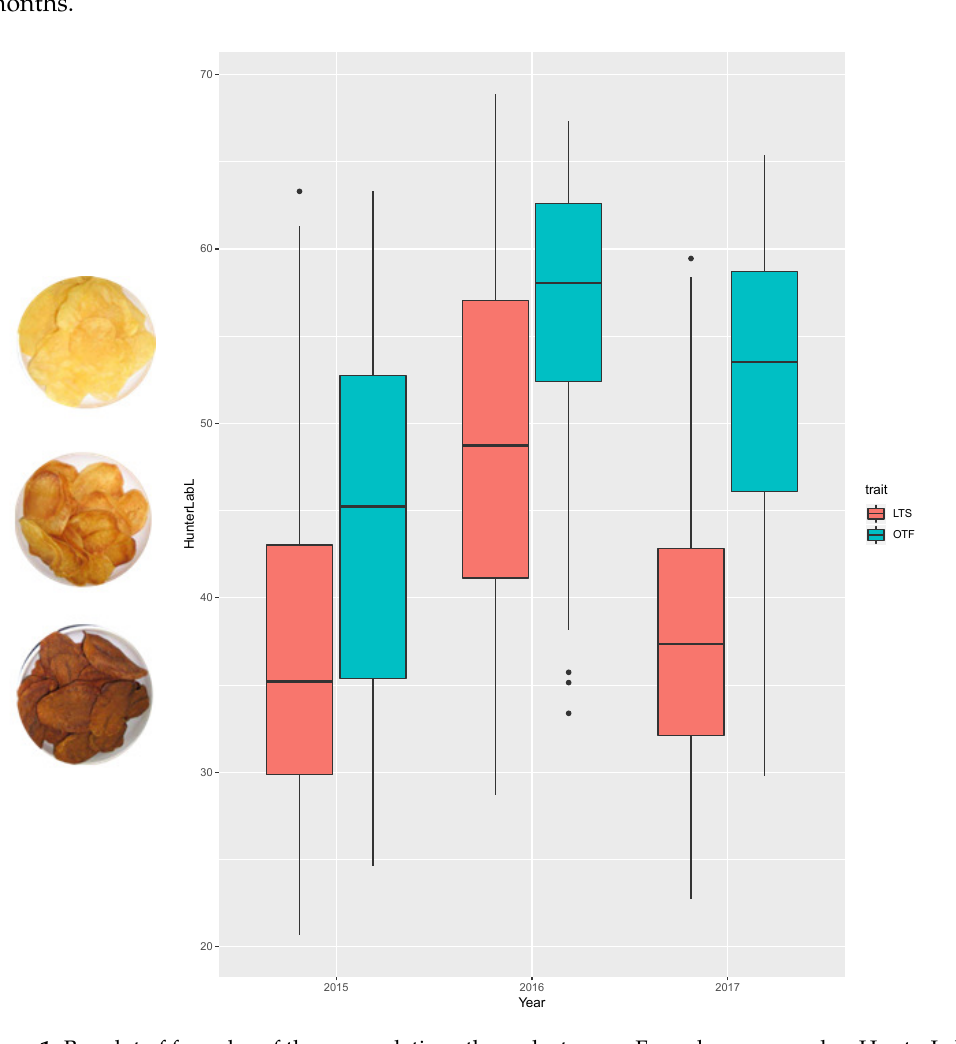
Figure 1. Boxplot of fry color of three populations through storage. Fry color measured as HunterLab L -values when fried ‘off-the-field’ (OTF) and after long-term storage at 4.5 ◦ C for ca. seven months